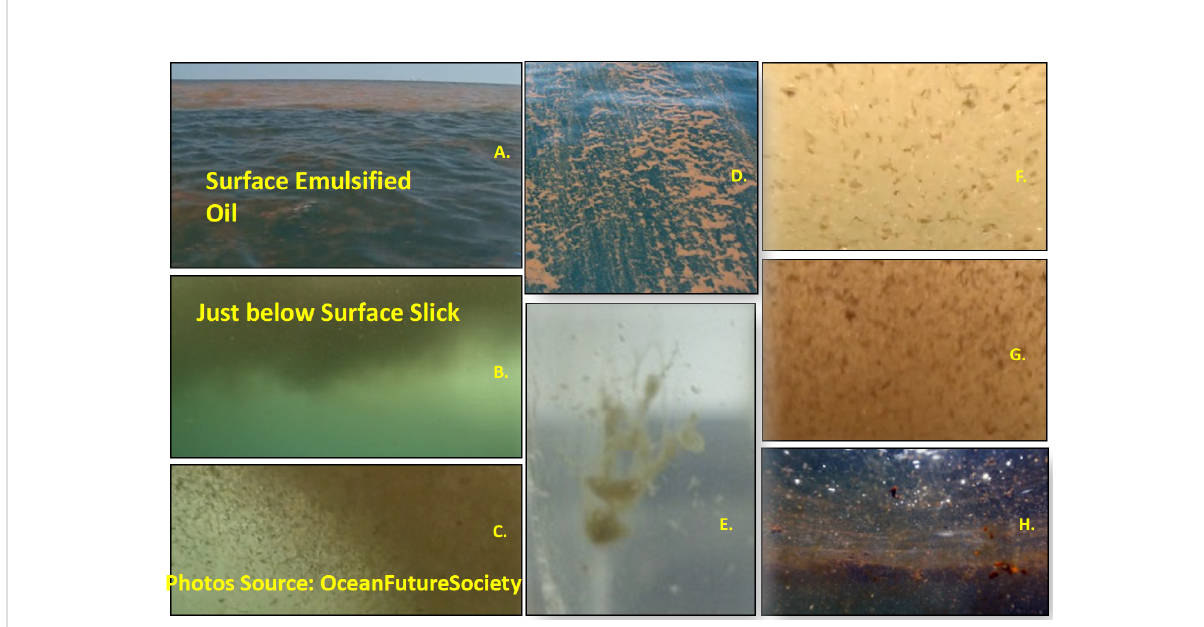
FIGURE 10 Photos of an emulsi fi ed surface slick and bacteria-oil agglomerations (BOA) suspended in the Gulf of Mexico water column just below the surface. The center picture insert (E) is a close-up of the EPS (extra polymeric substances) produced in a laboratory experiment showing the initial formation of MOS particles (marine oil snow) Pictures (A – C, F – H) were kindly provided with permission by the Oceans Future